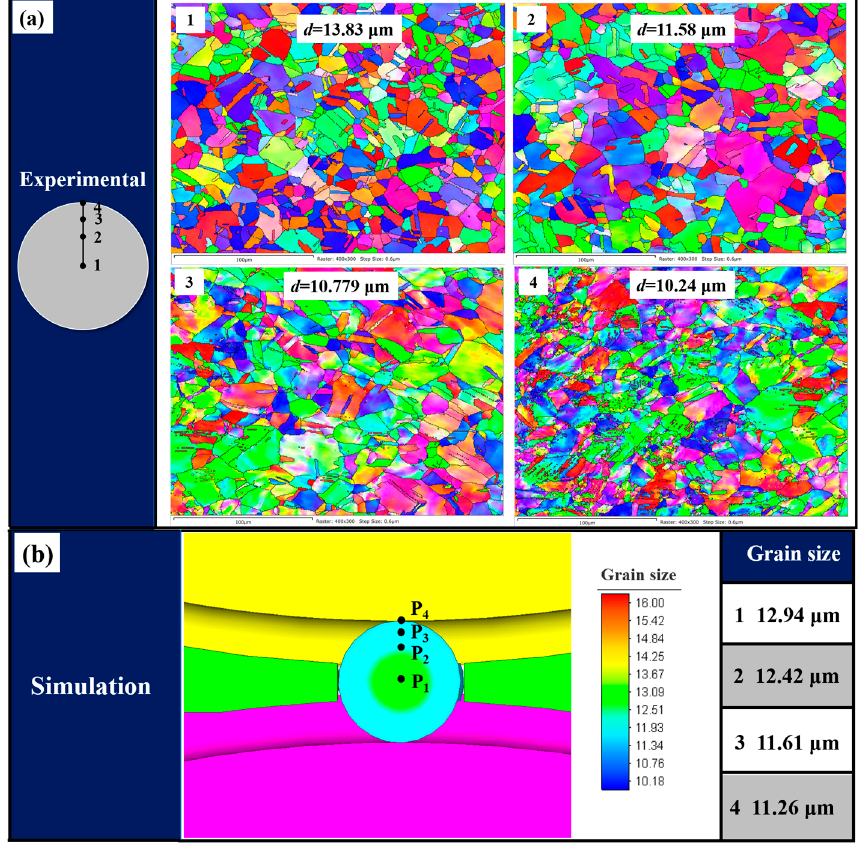
Figure 4. Comparison of grain size at di ff erent positions in transverse section of steel balls: ( a ) experimental results and ( b ) simulation results.